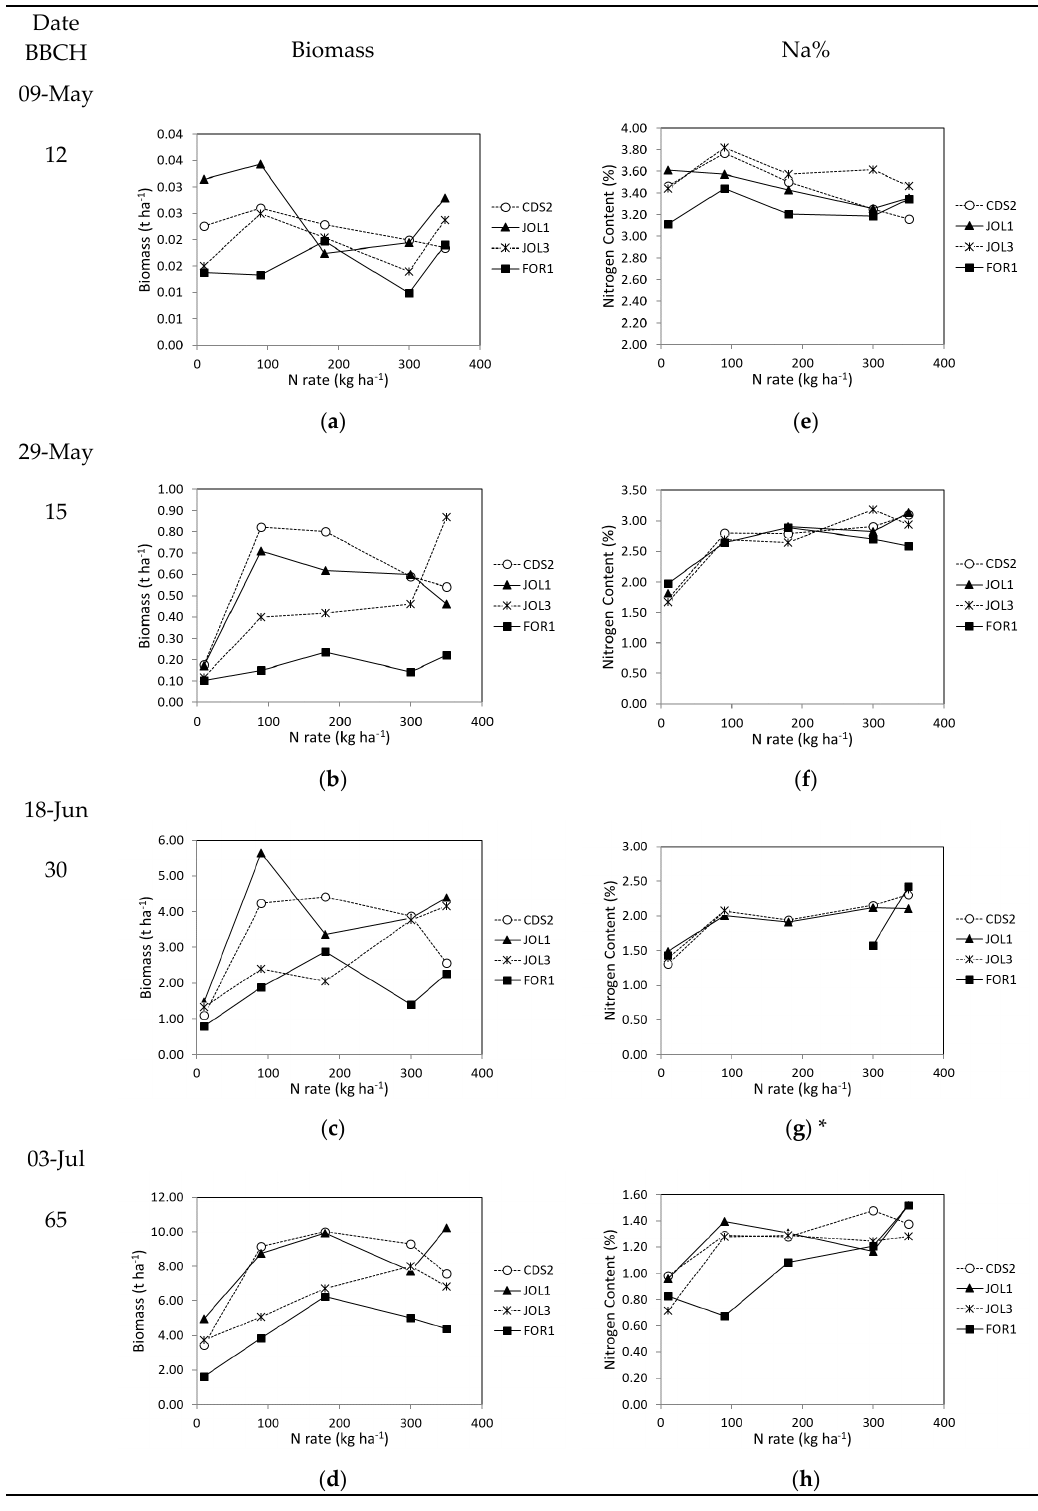
Figure 2. Response of maize above ground biomass and Na% to N fertilizer rates, measured during the 2018 field campaigns in the different soil classes (see Table 5): ( a ) 09-May BBCH 12; ( b ) 29-May BBCH 15; ( c ) 18-Jun BBCH 30; ( d ) 03-Jul BBCH 65. Plant nitrogen concentration ( e ) 09-May BBCH 12; ( f ) 29-May BBCH 15; ( g ) 18-Jun BBCH 30; ( h ) 03-Jul BBCH 65. * Na% missing values for the FOR1 class due to samples